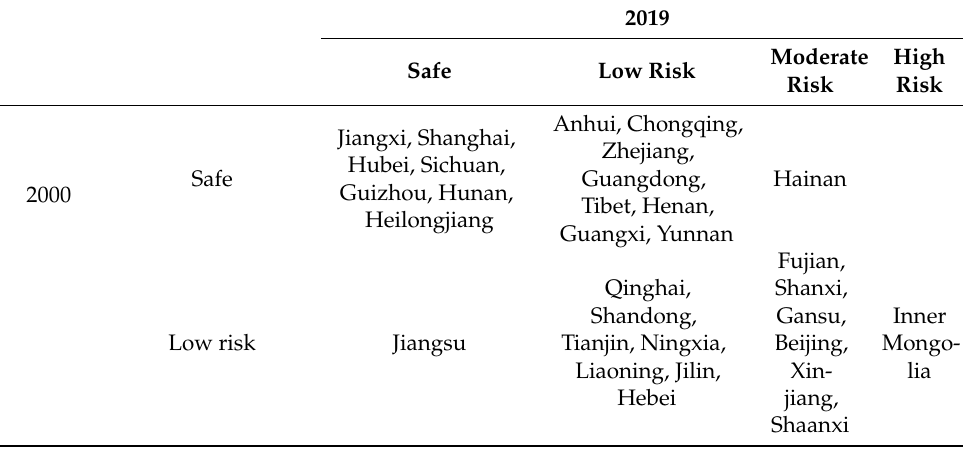
Table 2. Changes of the environmental risk type of provincial CFAI in China from 2000 to 2019.